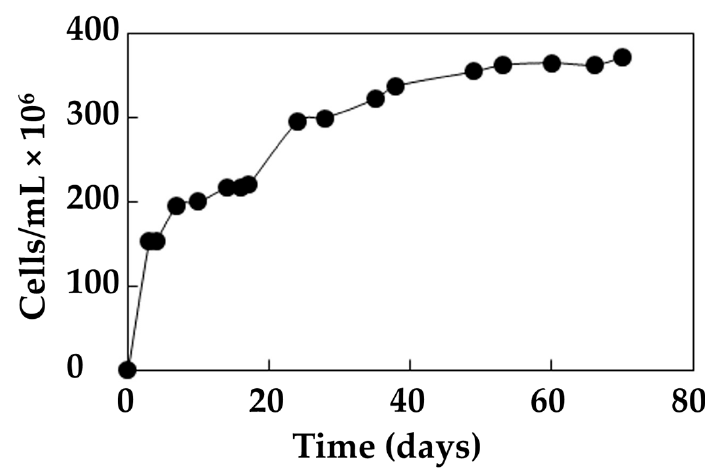
Figure 4. Growth of strain in 4.5 K medium.